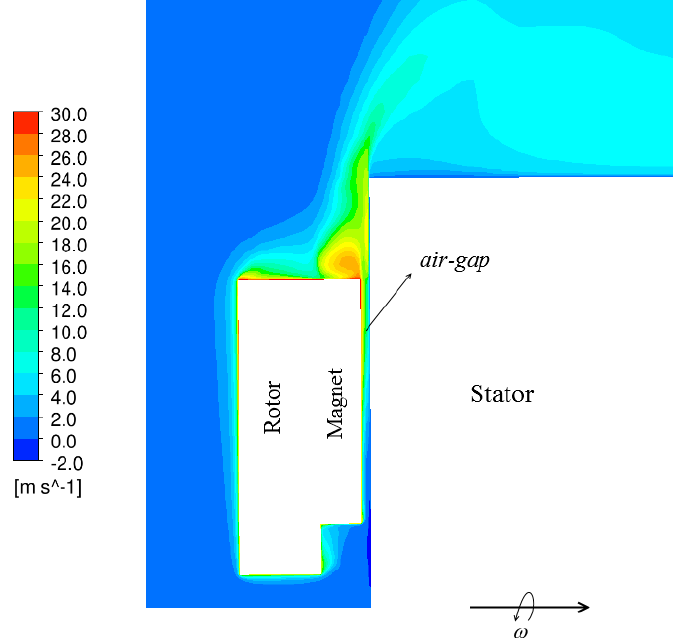
Figure 3. Absolute tangential velocity contour in the meridional plane through the center of the air-gap for G = 0.0135, Re = 1.06 × 10 5 , α m = 0.8 and L =